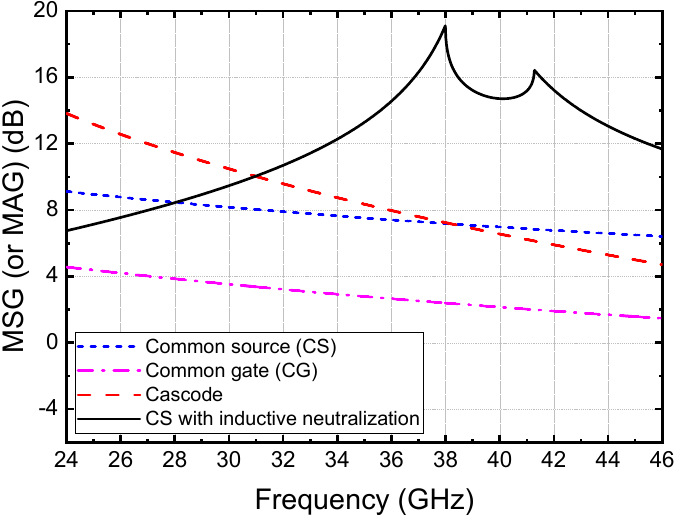
Figure 2. Comparison of MSG (or MAG) of different transistor topologies in a 65 nm CMOS technology.